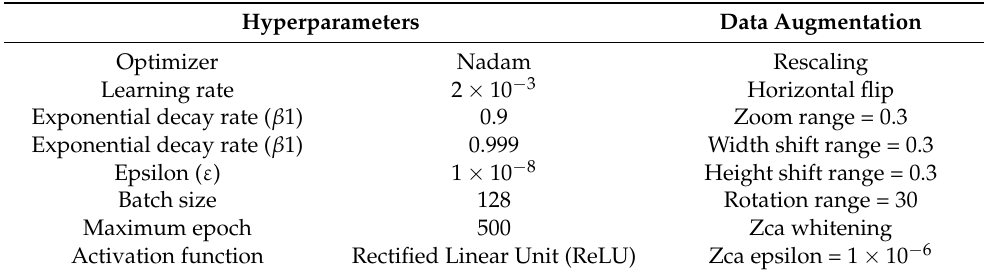
Table 1. CNN Training hyperparameters and data augmentation techniques.